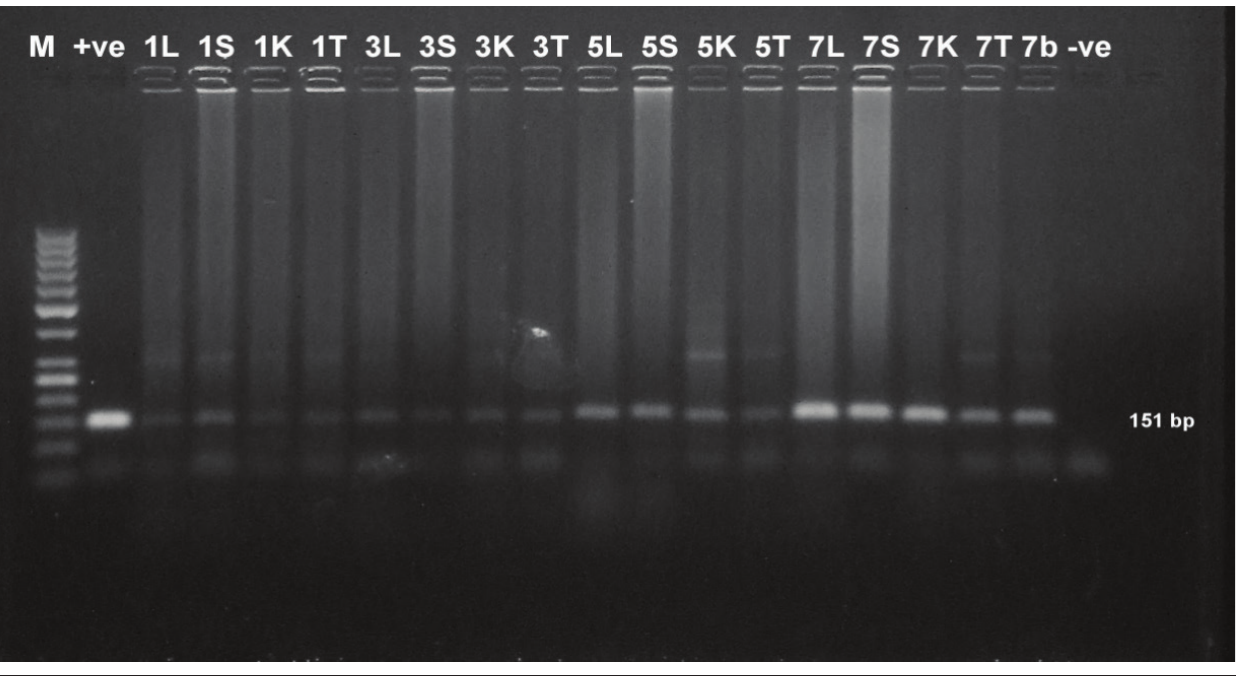
FIG URE 6: Polymerase chain reaction amplification of Deoxyribonucleic acid extracted from tissues of infected male mice (parasitaemic stage) using T. evansi Rode Trypanozoon antigen type primer set. M: 50 base pairs molecular weight Deoxyribonucleic acid marker, +ve: positive control, -ve: negative control, 1, 3, 5, 7: days post infection and L (liver), S (spleen), K (kidneys), T (testes) and B